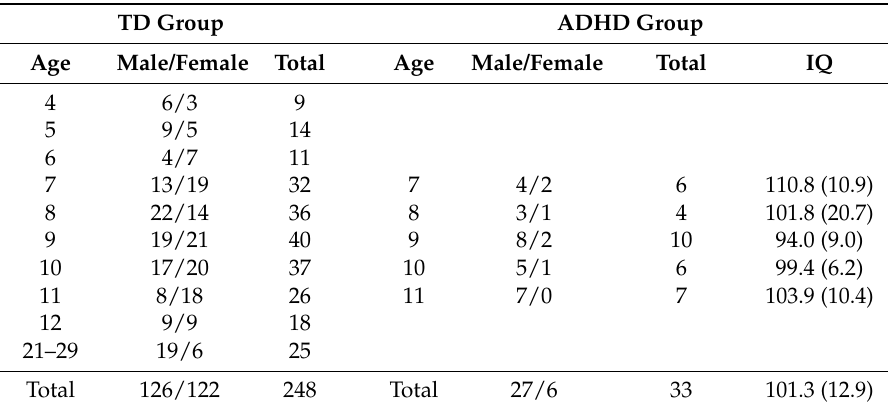
Table 1. Descriptive data of study